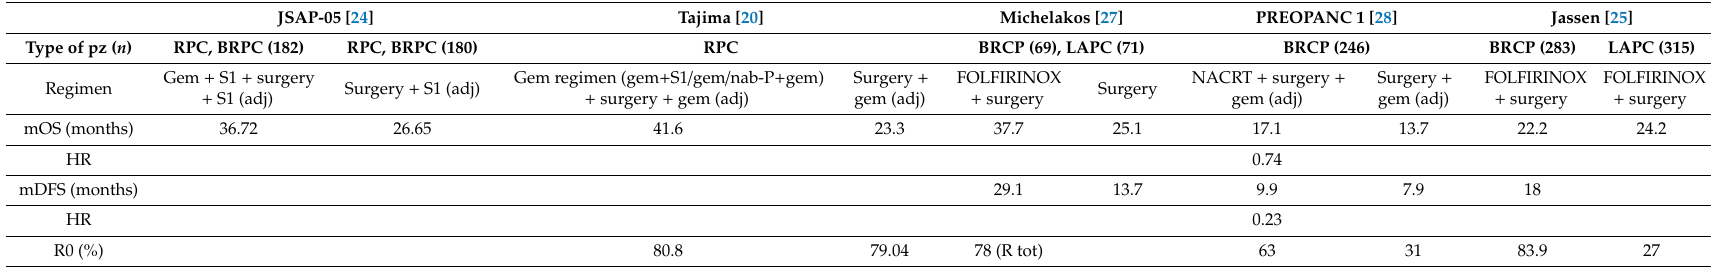
Table 1. Analysis of survival and R0 status with neoadjuvant treatments according to updated studies and reviews.